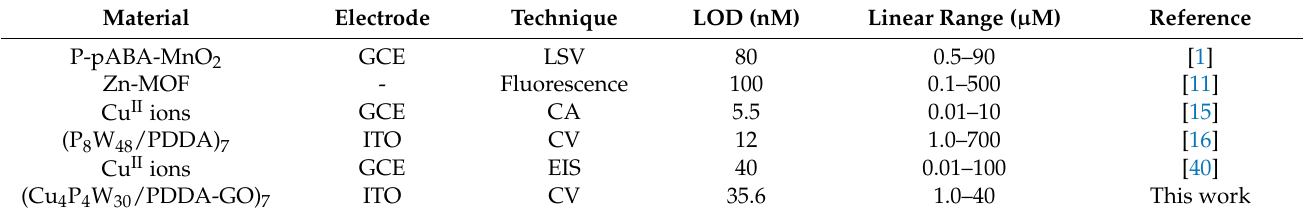
2.7. Stability, Reproducibility, and Repeatability Evaluation of the Film-Modified Electrodes Stability, reproducibility, and repeatability are very important indexes to evaluate the performance of electrochemical sensors in the sensing process. To determine whether the sensor response of the ITO/(Cu 4 P 4 W 30 /PDDA-GO) 7 electrode to 2,4-DNPH was repro- ducible, seven consecutive readings were taken in 10 µ M 2,4-DNPH at pH 7 using the same electrode. As shown in Figure 11a, the results indicate that the relative standard deviation (RSD) of the peak currents was 1.23% for the reduction peak at − 0.88 V and 2.60% for the oxidation peak at 0.36 V, meaning that the sensor prepared for the detection of 2,4-DNPH had good reproducibility. Furthermore, the repeatability of the ITO/(Cu 4 P 4 W 30 /PDDA- GO) 7 electrode was evaluated using five different electrodes prepared within five days, and their response currents to 10 µ M 2,4-DNPH at pH 7 was recorded (shown in Figure 11b), giving RSDs of 2.45% for the reduction peak at − 0.88V and 3.01% for the oxidation peak at 0.36 V, implying that the ITO/(Cu 4 P 4 W 30 /PDDA-GO) 7 electrode had good repeatability. Finally, the operational stability of the ITO/(Cu 4 P 4 W 30 /PDDA-GO) 7 electrode was